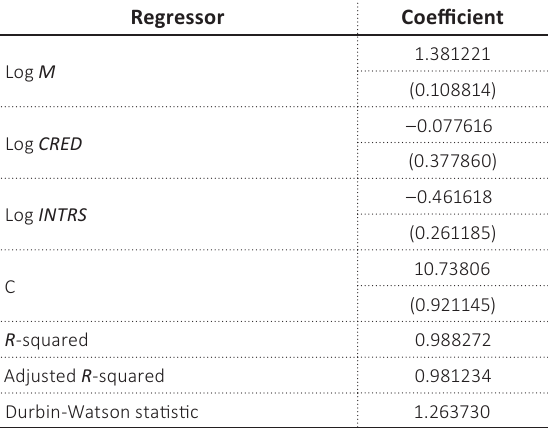
Table 2. Estimated coefficients of the equation using DOLS approach-dependent